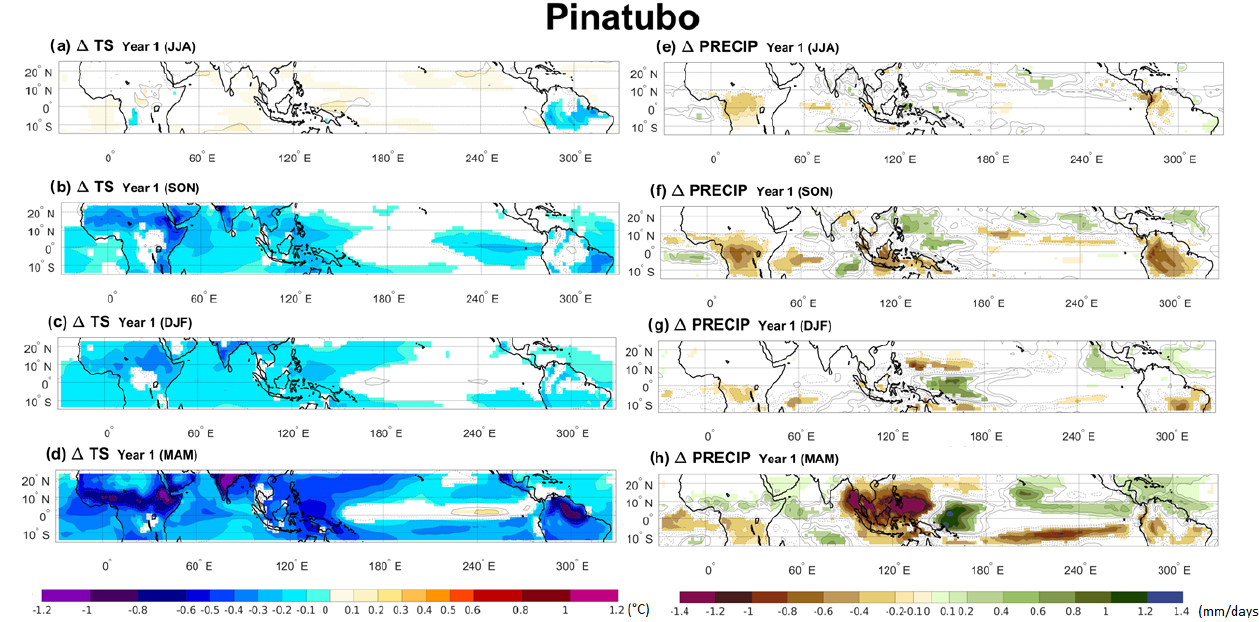
Figure A5. Ensemble mean of changes in surface temperature (a, b, c, d) and precipitation (e, f, g, h) between the climatology and the volcano case for each season of the year after the Pinatubo eruption. Only significant anomalies are shown with an approximate 95% confidence level using Student’s t test. Contours show temperature and precipitation anomalies following the colour bar scale (solid line for positive anomalies and dashed line for negative anomalies).